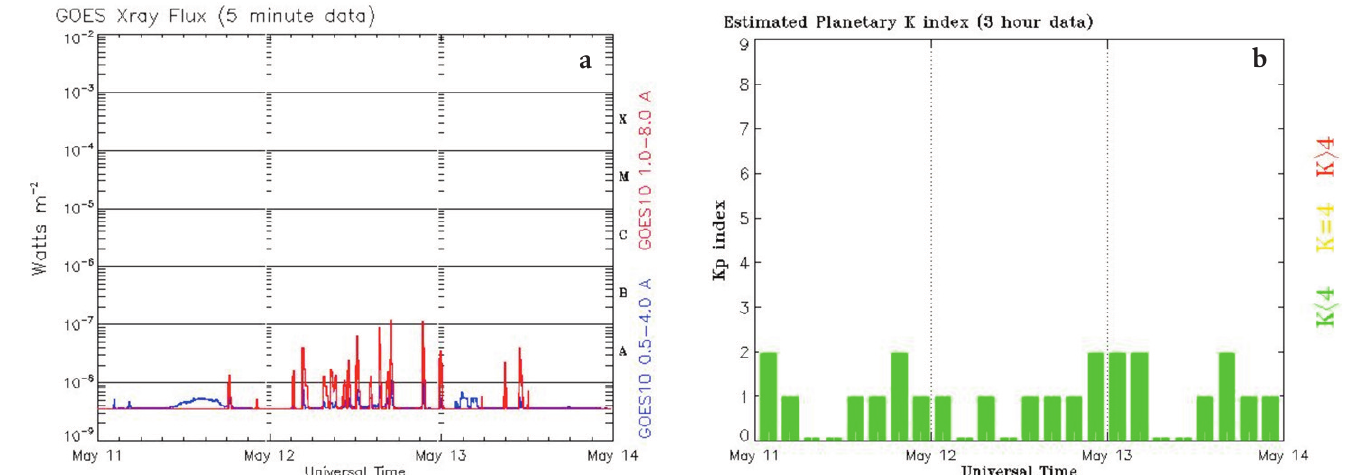
Figure 4. (a) X-ray flux data from May 11 to 13, 2008 (NOAA/NWS Space Weather Prediction Center). (b) Kp indices from May 11 to 13, 2008 (NOAA/NWS Space Weather Prediction